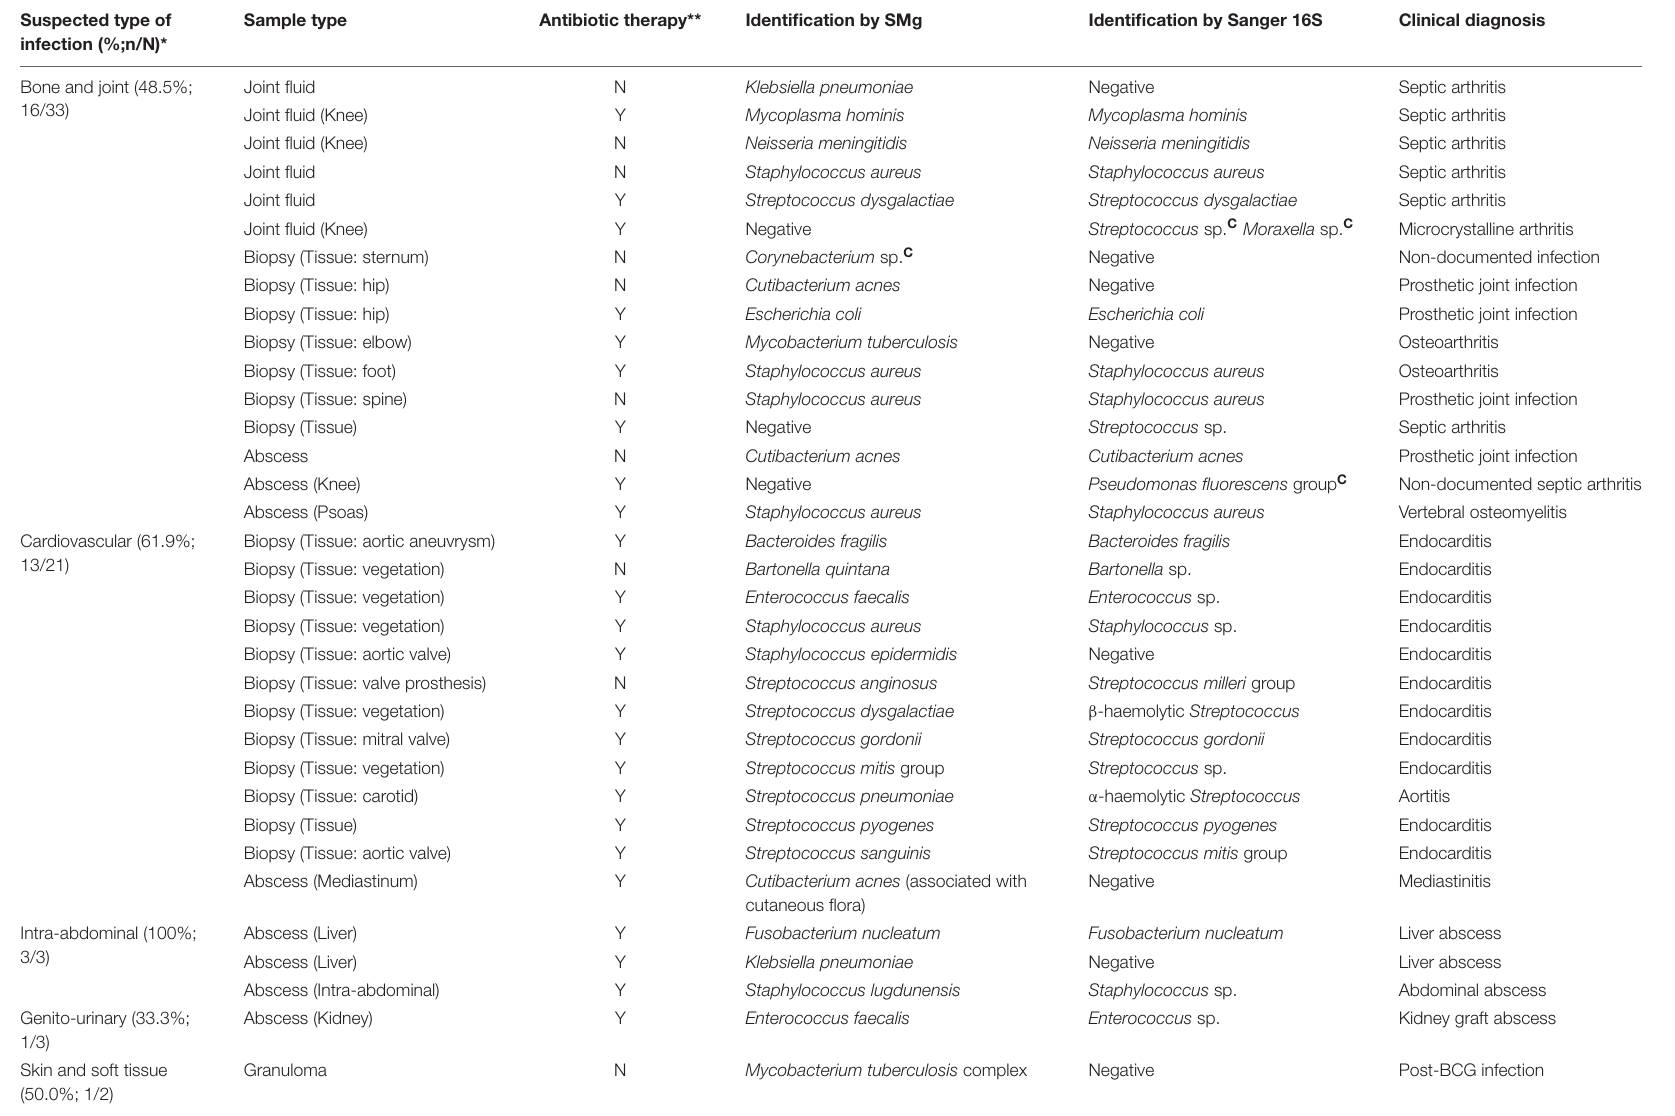
TABLE 1 | Clinical and biological data of the 34 positive samples detected positive with Sanger sequencing of the 16S rRNA gene (Sanger 16S) and/or shotgun metagenomics (SMg). Suspected type of infection